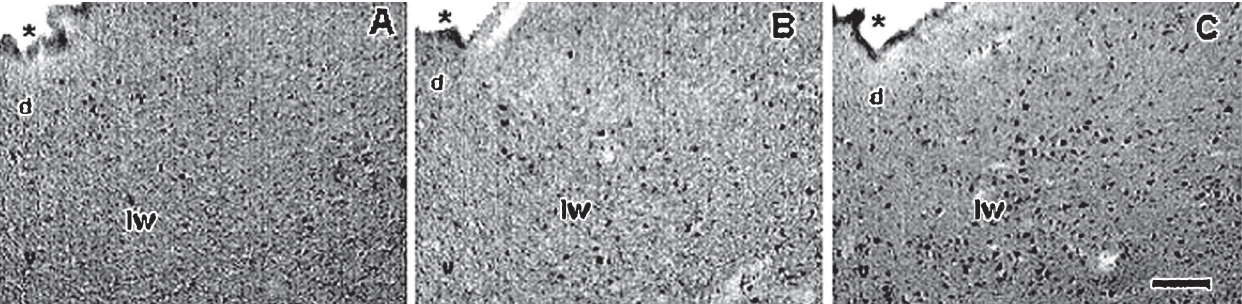
Figure 5. Photomicrograph illustrating the c-Fos expression induced by electroacupuncture (faradic wave, 2-4 V) in the dorsal raphe nucleus of animals previously submitted to 13 days of repeated immobilization. A , Rats only subjected to immobilization (IMMO); B , animals immobilized and submitted to electroacupuncture at a non-acupoint site (EANP); C , animals immobilized and submitted to EA36S (Zusanli point). * = brain aqueduct; d = dorsal part; lw = lateral wings of dorsal raphe nucleus; v = ventral part. Magnification bar: ~140 µm. . . . . Note that in C there is a higher number of c-Fos- immunoreactive cells in comparison with A and B